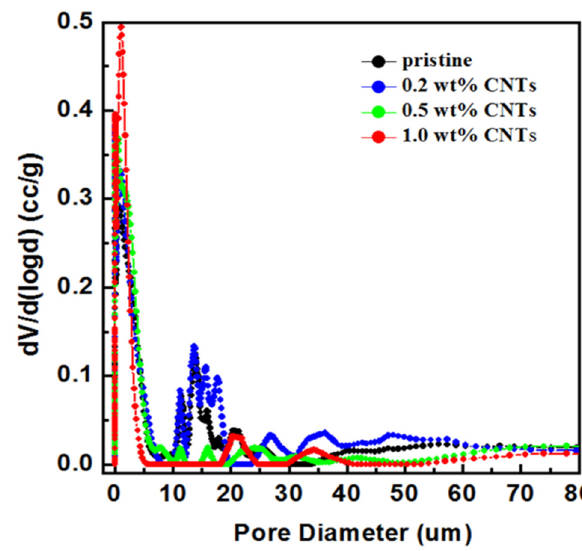
Figure 3. Pore size distribution of hollow fibre membranes analysed by mercury intrusion